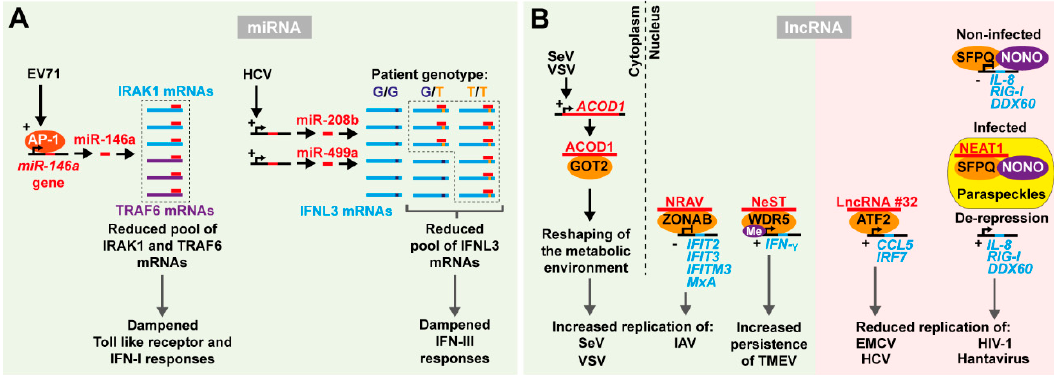
Figure 2. Indirect interactions between RNA viruses and host ncRNAs affect viral replication. ( A ) MiRNA expression induced by viruses to dampen IFN responses. When cells are infected by EV71, miR-146a expression is induced by the transcription complex AP-1. MiR-146a then binds and represses its mRNA targets, IRAK1 and TRAF6, impairing the activation of Toll-like receptors and the IFN-I response. HCV infection upregulates the miR-208b/499a cluster. These miRNAs target the 3 ′ UTR of IFNL3 mRNAs, counteracting the activation of the IFN-III response. In patients carrying a specific single nucleotide polymorphism in the miRNA seed region (G (dark blue) instead of T (orange)) targeting is abolished resulting in restored gene expression. This polymorphism is associated with clearance of the infection versus persistence. ( B ) LncRNAs affect viral infection. LncRNA ACOD1 accumulates in the cytoplasm upon SeV and VSV infection and binds the GOT2 protein to re-shape the metabolic landscape of the cell and promote viral replication. In the nucleus, different mechanisms with opposite effects can take place: lncRNA NRAV binds the transcription factor ZONAB to repress ISGs and promote IAV replication; lncRNA NeST binds the histone methyl transferase WRD5 leading to histone methylation and expression of the IFNG gene, which increases TMEV persistence; on the contrary, binding of lncRNA #32 to the transcription factor ATF2 activates ISGs and reduces replication of EMCV and HCV; a similar effect is observed for HIV-1 and hantavirus due to the derepression of ISGs following the sequestration of the transcription regulator complex SFPQ-NONO by lncRNA NEAT1 to paraspeckles.